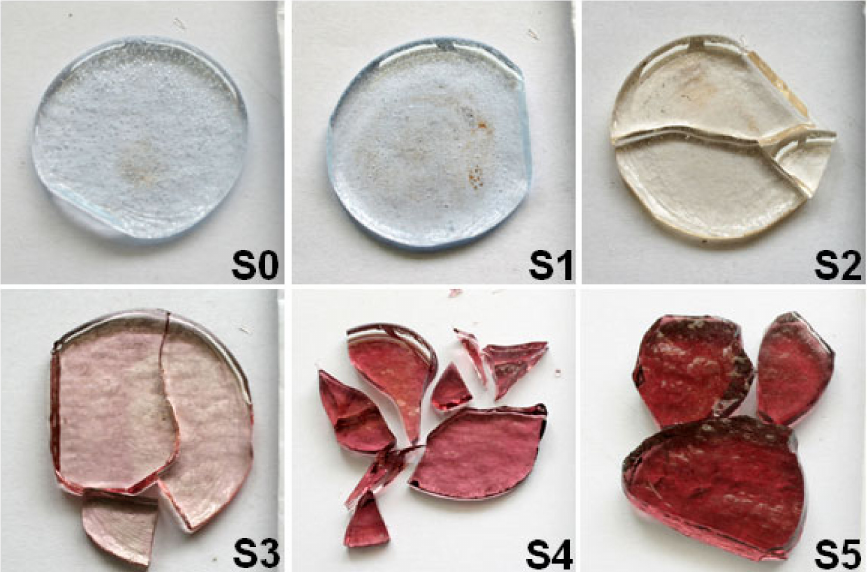
Figure 1. Synthesized agriglass samples.